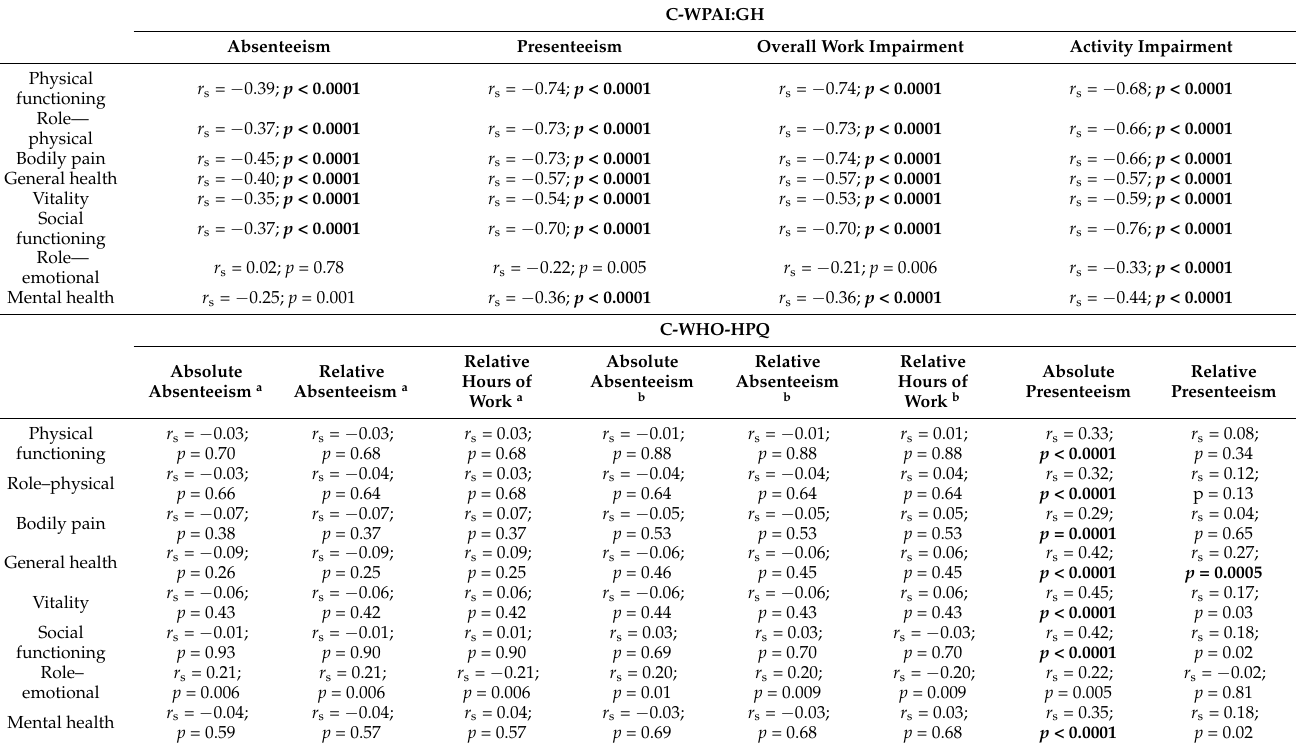
Table 2. Associations of the C-WPAI:GH and C-WHO-HPQ with the Short Form (SF-36) using Spearman’s correlation coefficients ( r s and p